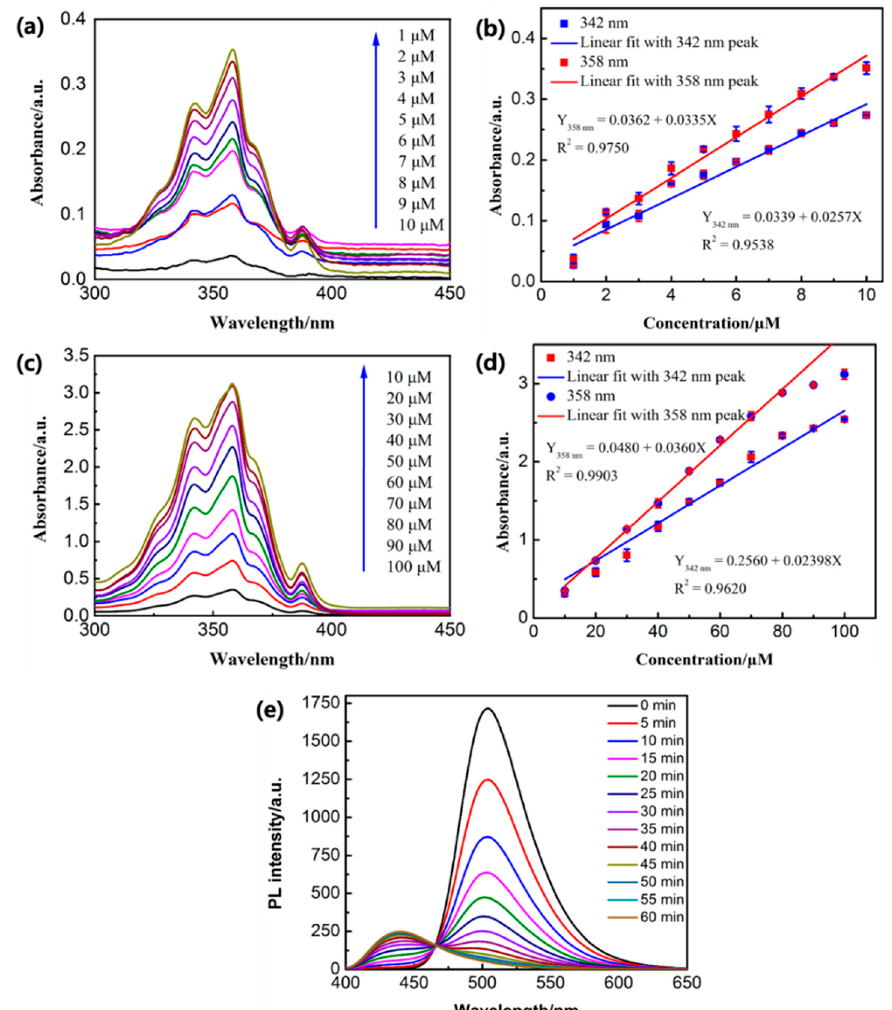
Figure 7. ( a , c ) UV–Vis absorption spectral changes of PE with different ranges of concentration (from 1–10 μ M) and (from 10–100 μ M). ( b , d ) linear regression corresponding to the different range of concentration showing the absorbance peaks at 342 nm and 358 nm. ( e ) PL titrations of PE (100 μ M) in CH 3 CN with Fe 3+ were exposed in air within 60 min.